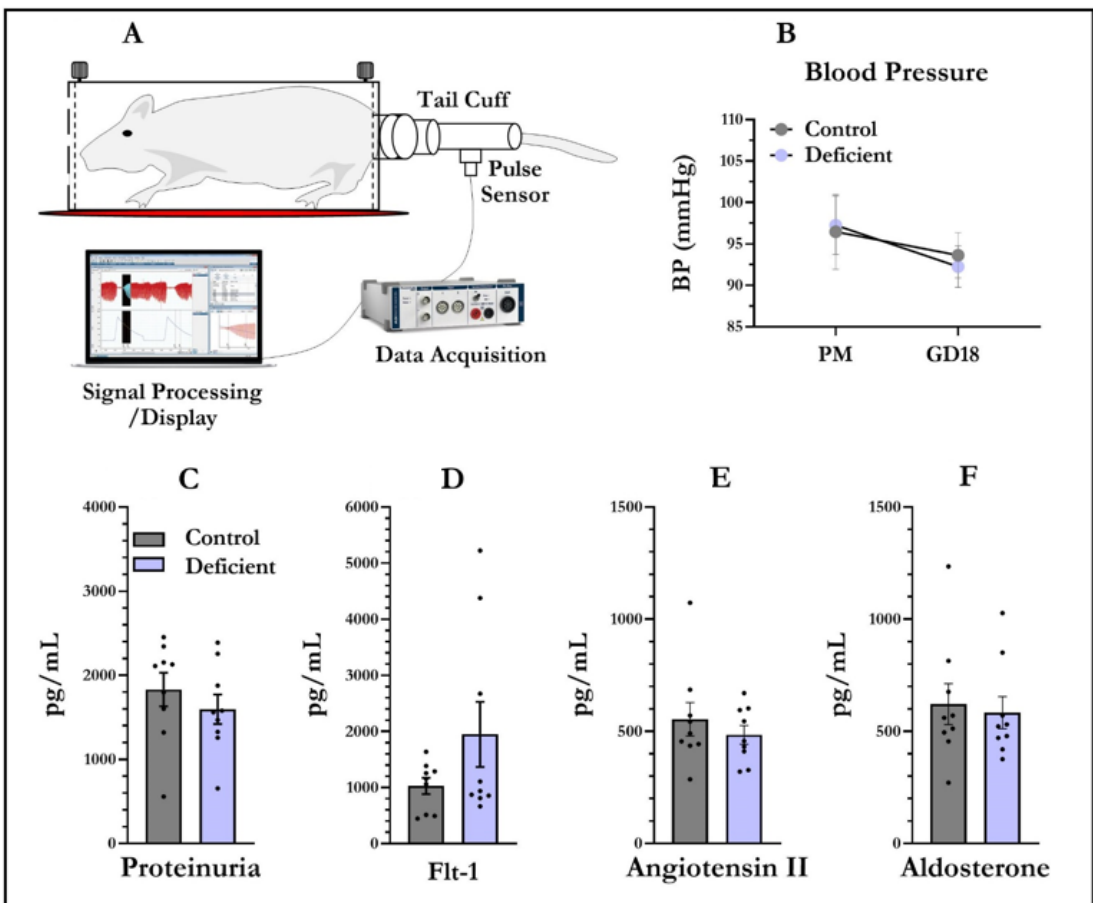
Figure 1. Vitamin D-deficient pregnant rats do not display preeclampsia phenotypes. Blood pressure data were acquired and processed using LabChart ® 8.1 ( A ). Blood pressure was recorded from virgin and pregnant rats ( B ). There was no significant effect of diet on blood pressure at both time points. No proteinuria difference was detected in vitamin-D-deficient dams ( C ). Maternal Flt-1 ( D ), angiotensin II ( E ) and aldosterone ( F ) were also not significantly changed between the sera of control and vitamin-D-deficient dams. Data shown are means; error bars show SEM; n = 9 control, n = 9 vitamin-D-deficient, PM = prior to mating, GD18 = gestational day